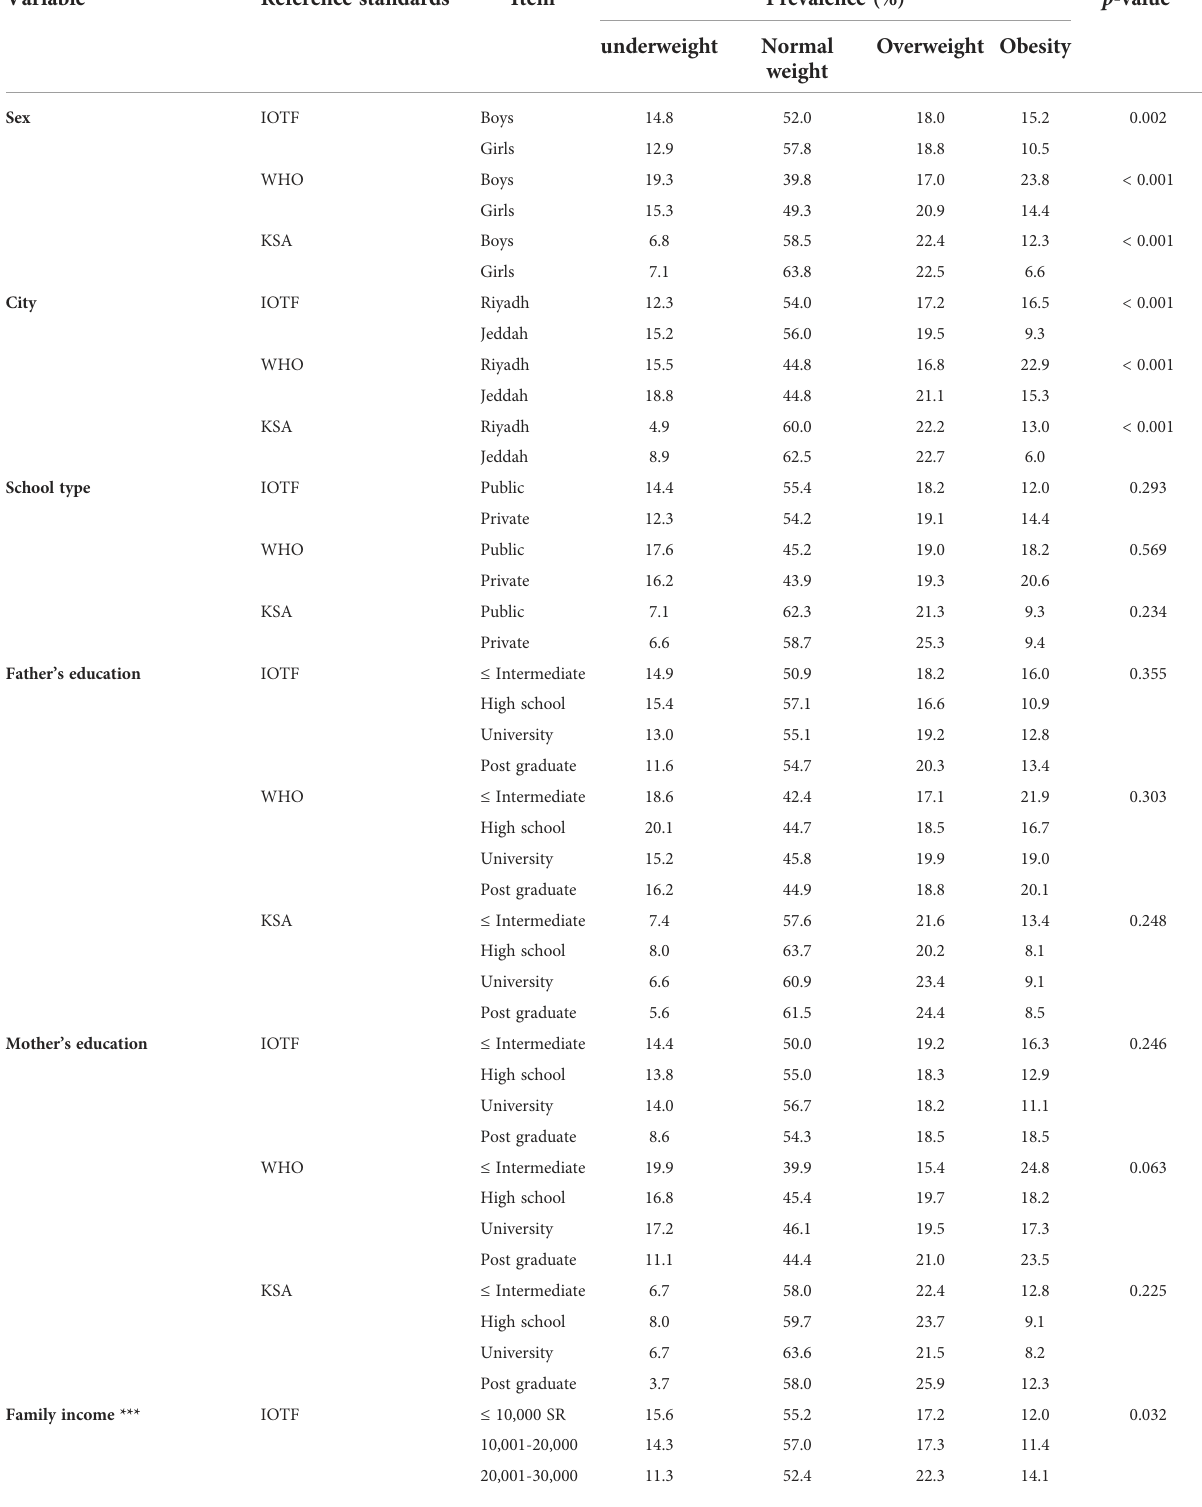
TABLE 3 The prevalence of underweight, normal weight, overweight, and obesity among Saudi children using IOTF or WHO reference standards relative to selected variables. Variable Reference standards * Item Prevalence (%) p -value **